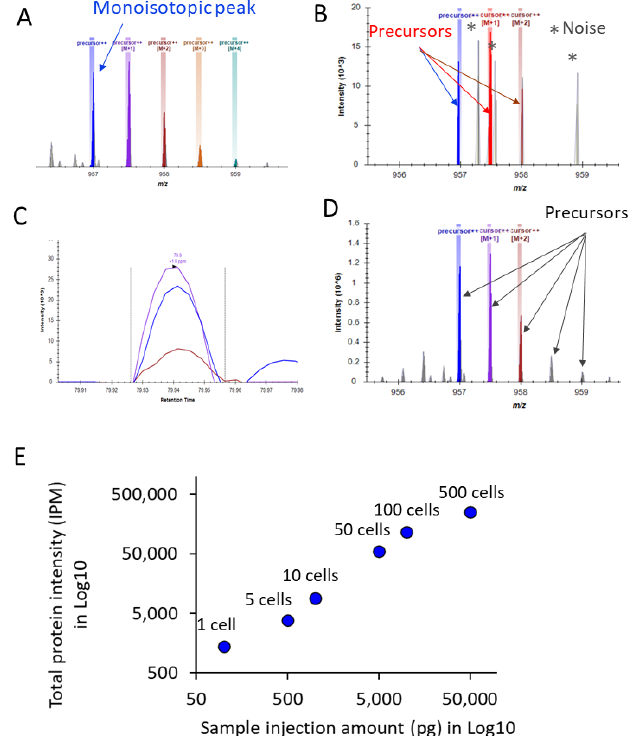
Figure 2. Exemplification of spectral matching and peak extraction using peptide LGGSLADSYLDEGFLLDK (CCT2) as an example. ( A ) Isotopic envelope of the peptide. ( B ) Isotopic distribution matching of the first 3 isotopic peaks detected in a pseudo single-cell sample (idotp score 0.77). The peaks in grey color are random noise. ( C ) Elution profile of the peptide detected in a pseudo single-cell sample. ( D ) Isotopic distribution matching of the first 3 isotopic peaks detected in a pseudo 500-cells sample (idotp score 0.99). ( E ) Correlation of the total normalized intensities of the proteins identified in the pseudo single-cell samples with the sample injection amount.